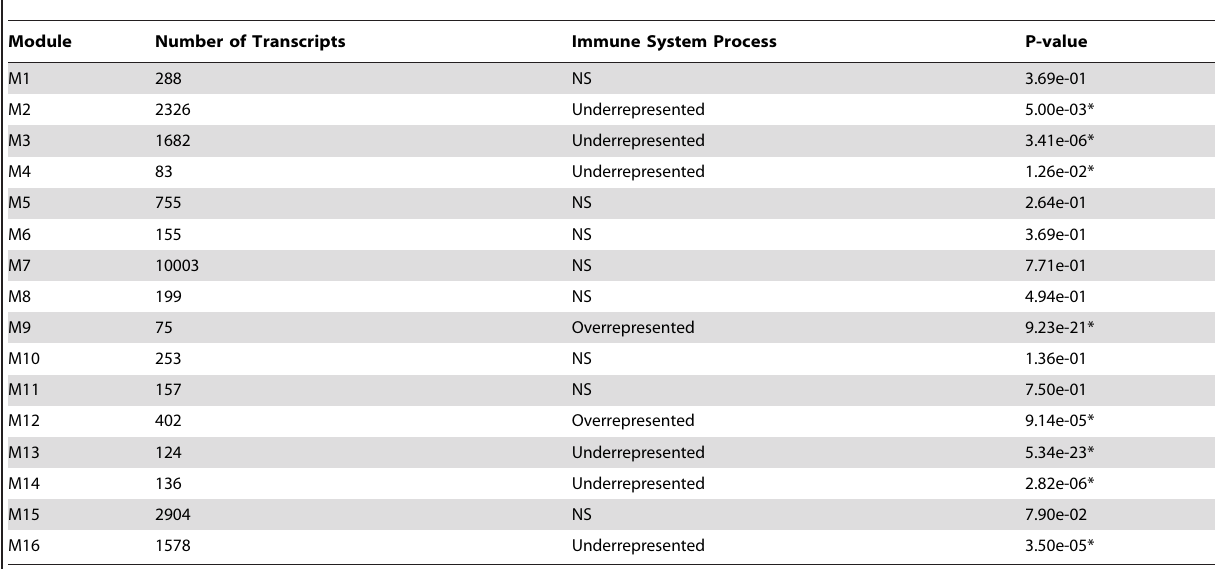
Table 1. Gene expression modules identified in RA CD4 + T